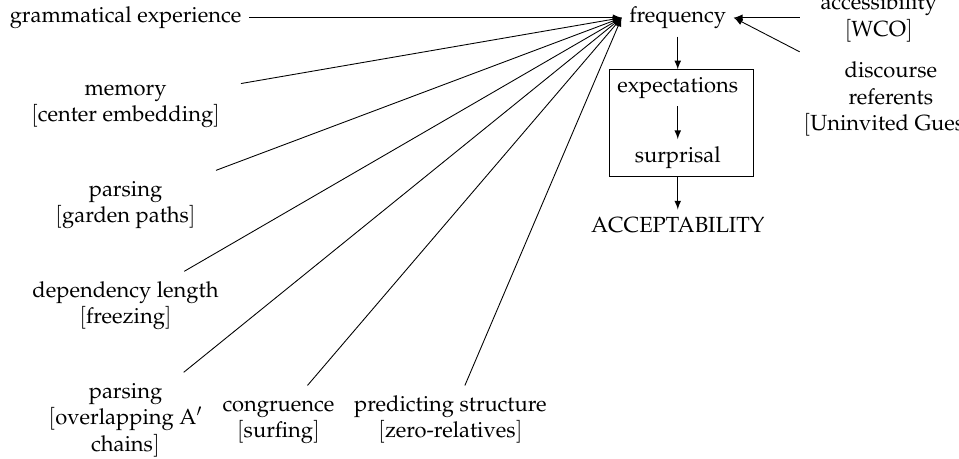
Figure 8. The logic of acceptability judgments for grammatical conditions, version